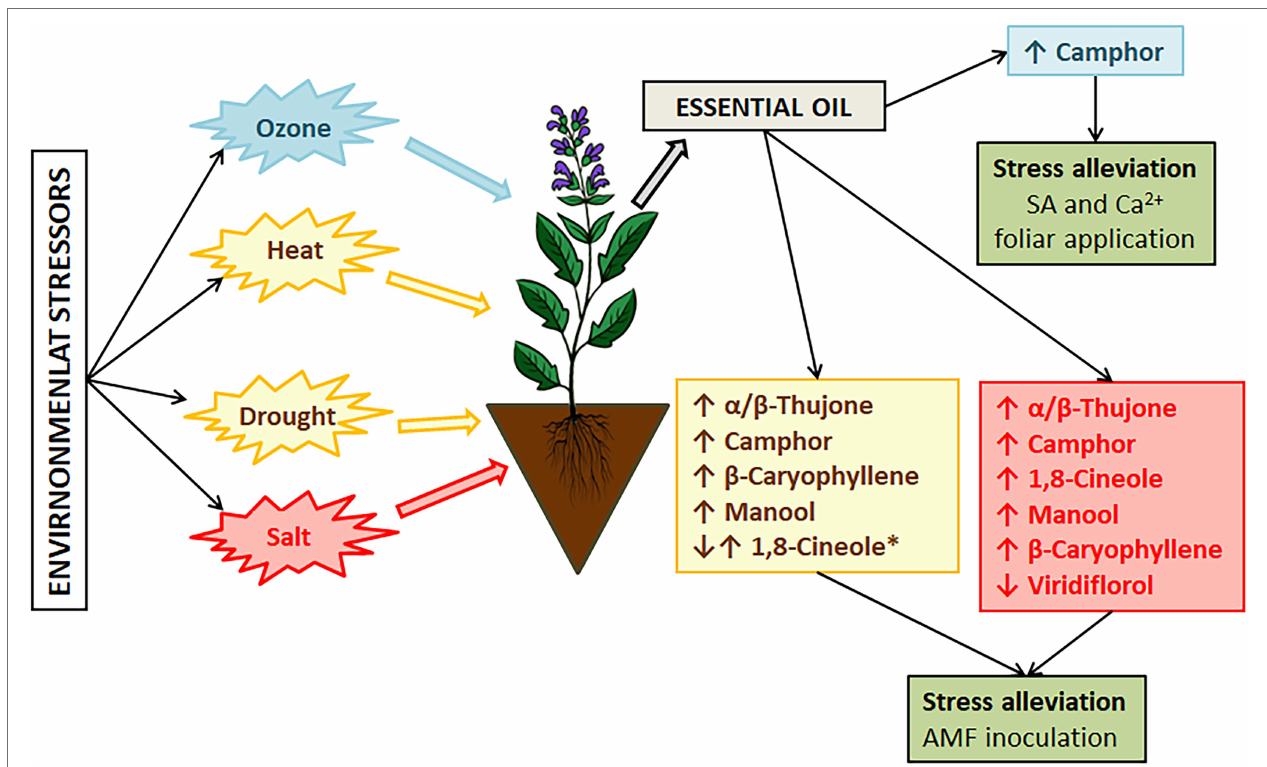
FIGURE 3 | The major changes in sage essential oil composition induced by environmental stressors. * Changes of 1,8-cineole levels also depends on sage